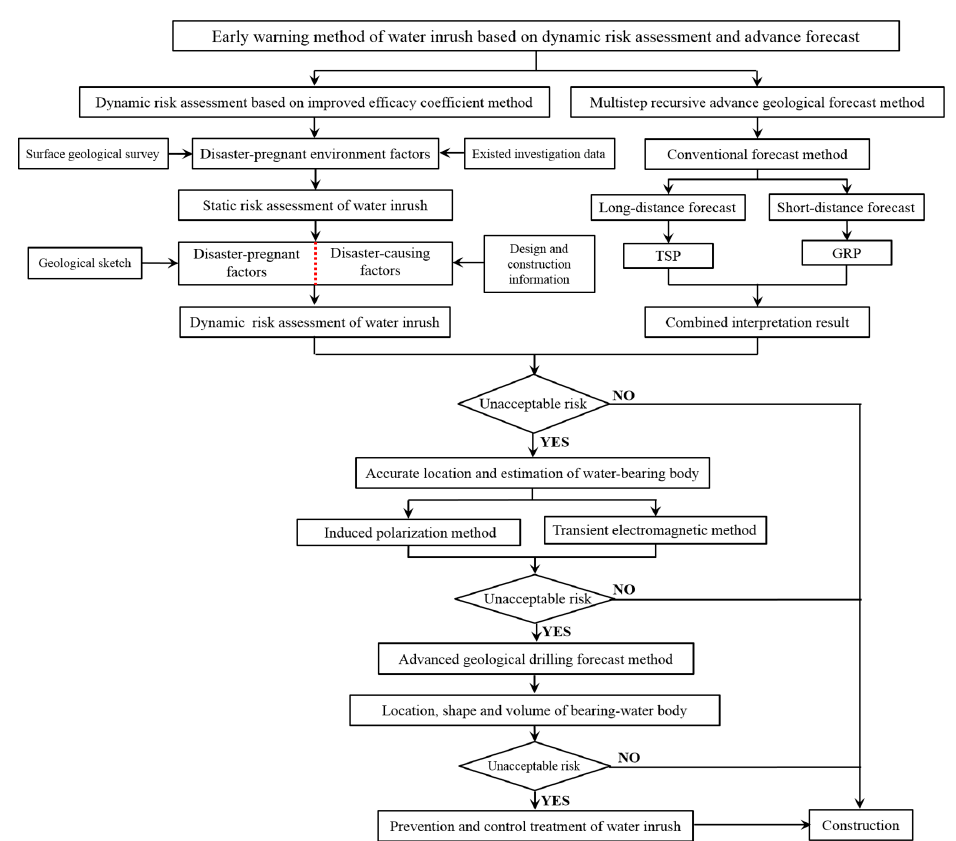
Figure 1. Early warning method of water inrush based on dynamic risk evaluation and advance forecast.